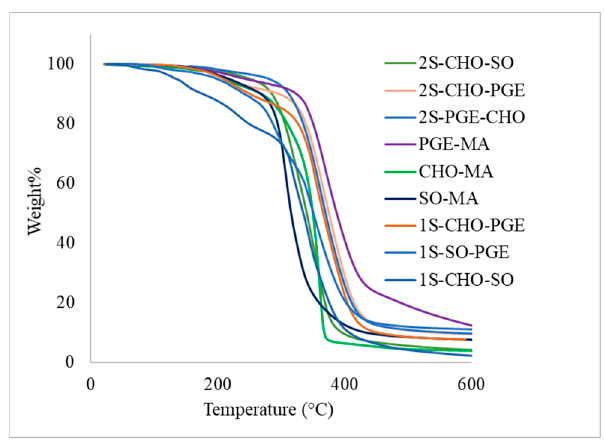
Figure3. TGAprofilesofthecopolymersandterpolymers(1Sforone-stepand2Sfortwo-step Figure 3. TGA profiles of the copolymers and terpolymers (1S for one-step and 2S for two-step reactions).